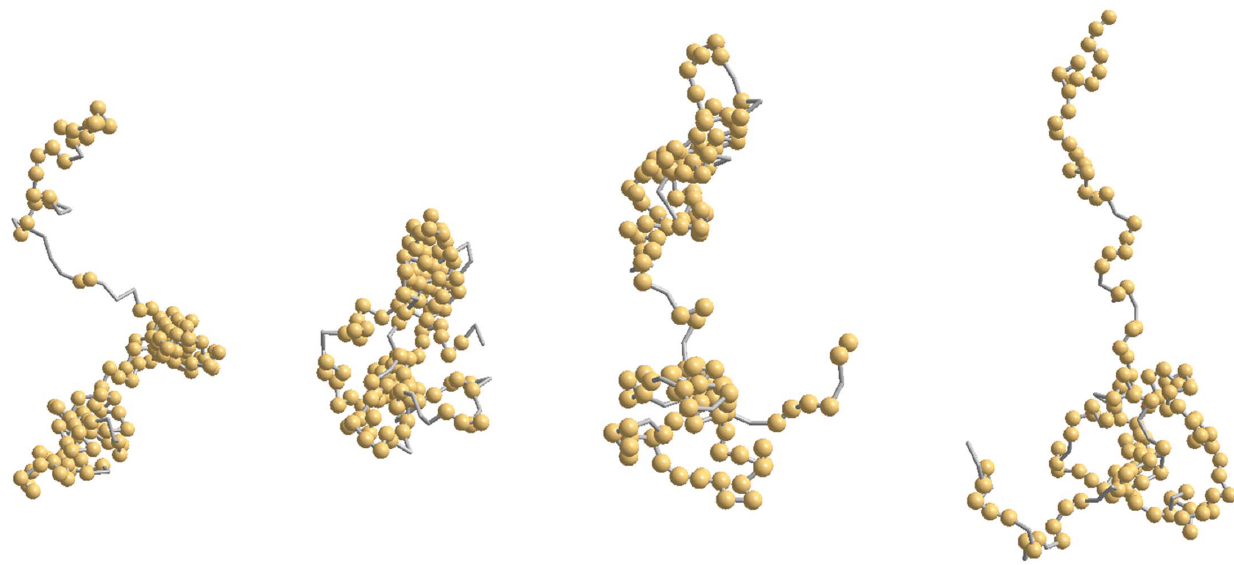
Figure 1. Snapshots of the histone H2AX at t=10 7 time step at the temperatures T=0.020,0.022,0.025,0.032 (left to right) using BT potential [ 7 ] ; residues within the range of interaction are spheres (other than the adjacent).